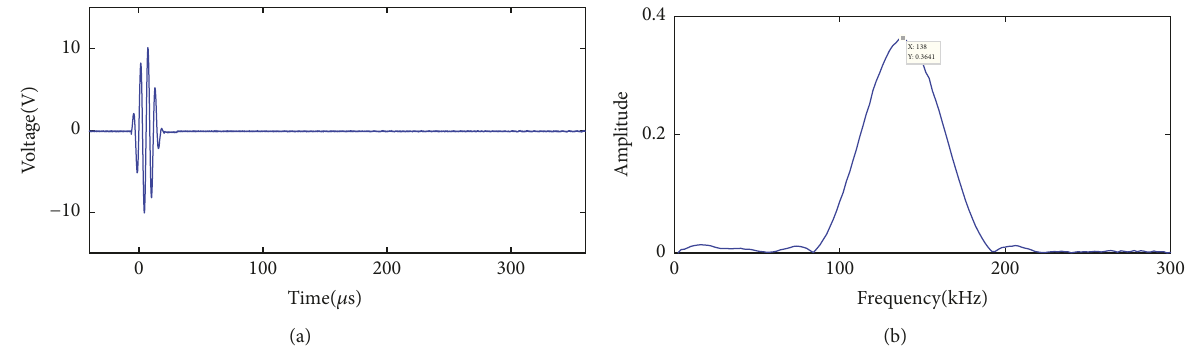
Figure 6: (a) Time-domain and (b) frequency-domain excitation signal of experiment.